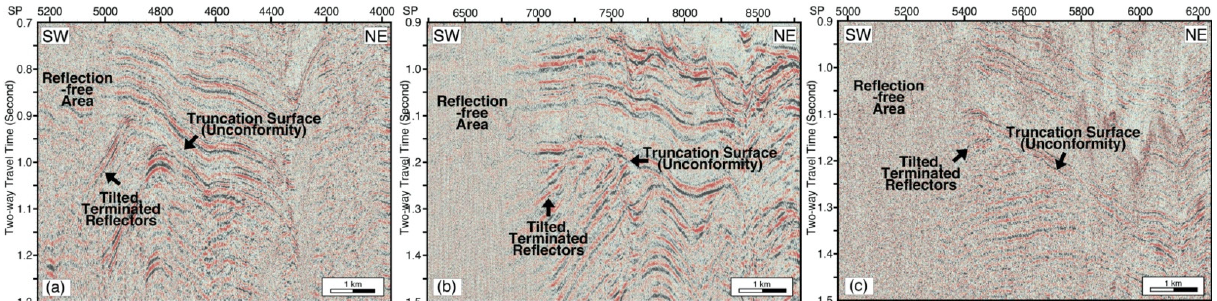
Figure 8. Terminated reflectors and truncating, unconformable surface. ( a ) Tilted reflectors revealed in Profile A (Figure 4). ( b ) Tilted reflectors revealed in Profile B (Figure 5). ( c ) Tilted reflectors revealed in Profile C (Figure 6).